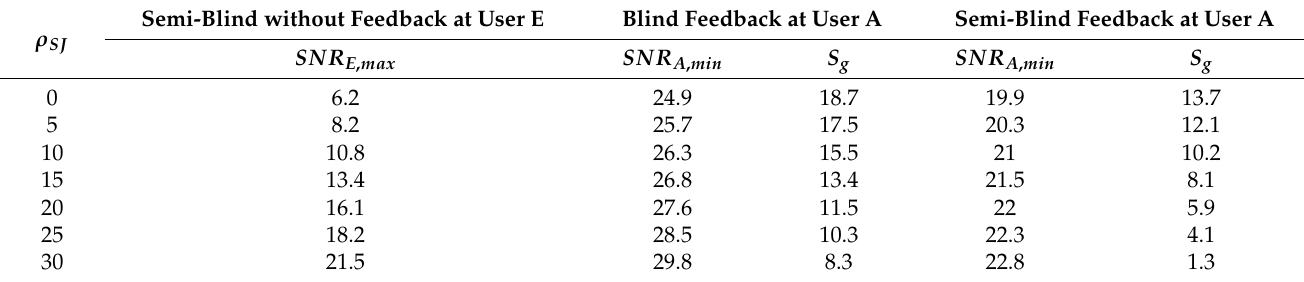
Table 5. The security gap when applying the semi-blind scheme without feedback at user